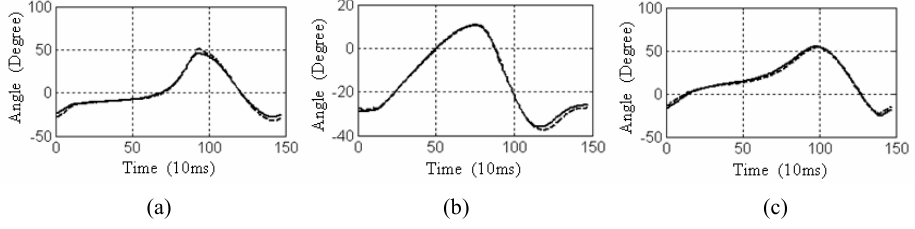
Fig. 4. Segmental angular displacements measured by wearable sensor systems (solid line) and Hi-DCam camera systems (dashed line). (a) Foot angular displacements. (b) Calf angular displacements. (c) Thigh angular displacements.